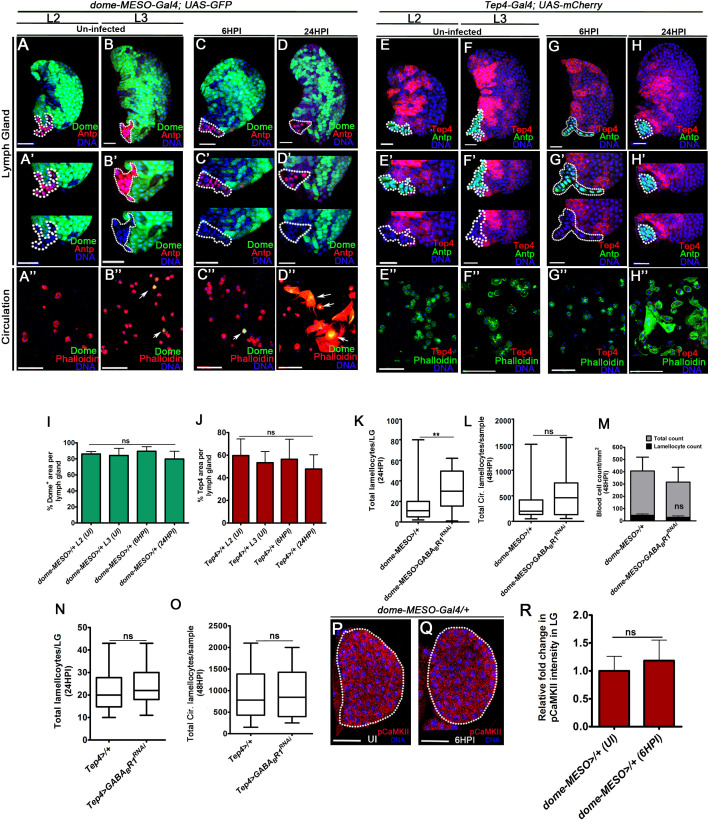
GABA receptor signaling is not required for lamellocyte formation.UI is uninfected, HPI is hours post wasp-infection. Scale bars in panels (A–H’’), and P and Q = 20 µm. In lymph gland, lamellocytes are analyzed at 24HPI and in circulation at 48HPI. Panels (I, J, M and R) represents mean ± standard deviation (mean ± SD) and in (K, L, N and O) median is shown in box plots and vertical bars represent upper and lowest cell counts and panel. Statistical analysis in panels (I, J, M and R) is unpaired t-test, two-tailed and in panels (K, L, N and O) is Mann-Whitney, two-tailed and. ‘n’ represents the total number of larvae analyzed, and for lymph gland ‘n’ represents lymph gland lobes analyzed. ns is nonsignificant. For better representation of the lymph gland primary lobes, the images shown, have been edited for removal of adjacent tissues (like dorsal vessel and ring gland). (A, B’’) dome-MESO expression (green, dome-MESO-Gal4, UAS-GFP) at (A–A’’) 2nd instar (L2) and (B–B’’) 3rd instar larval stage (L3) is restricted to (A, B) progenitor cells of the lymph gland and (A’, B’) not seen in the posterior signaling center (PSC; marked with Antp in red, and outlined with a white dotted line). (A’’, B’’) dome-MESO expression (green) is detected sparingly in circulating blood cells. Phalloidin (red) marks all blood cells and arrows point to blood cells that are dome positive (green). (C, D’’) dome-MESO expression (green, dome-MESO-Gal4, UAS-GFP) at (C–C’’) 6HPI and (D–D’’) 24HPI is seen in the (C, D) lymph gland progenitor cells and (C’, D’) not in the PSC (marked with Antp in red, and outlined with a white dotted line). (C’’, D’’) dome-MESO expression (green) is detected sparingly in circulating blood cells at (c’’) 6HPI, but is more prominent at (D’’) 24HPI. Phalloidin (red) marks all blood cells, including lamellocytes (large flat cells) and arrows point to blood cells that are dome positive (green). (E, F’’) Tep4 expression (red, Tep4-Gal4, UAS-mCherry) at (E–E’’) 2nd instar (L2) and (F–F’’) 3rd instar larval stage (L3) is restricted to (E, F) progenitor cells of the lymph gland and (E’, F’) not seen in the PSC (marked with Antp in green and outlined with a white dotted line). (E’’, F’’) Tep4 expression (red) is not detected in circulating blood cells. Phalloidin (green) marks all blood cells. (G, H’’) Tep4 expression (red, Tep4-Gal4, UAS-mCherry) at (G–G’’) 6HPI and (H–H’’) 24HPI is seen in the (G, H) lymph gland progenitor cells and (G’, H’) not in the PSC (marked with Antp in green and outlined with a white dotted line). (G’’, H’’) Tep4 expression (red) is not detected in circulating blood cells. Phalloidin (green) marks all blood cells. (I) Quantification of percentage area of dome-positive expression in the lymph glands obtained from 2nd instar dome-MESO-Gal4, UAS-GFP, uninfected (n = 8), 3rd instar dome-MESO-Gal4, UAS-GFP, uninfected (n = 13), dome-MESO-Gal4, UAS-GFP, 6HPI (n = 17, ns compared to 2nd instar dome-MESO-Gal4, UAS-GFP, uninfected) and dome-MESO-Gal4, UAS-GFP, 24HPI (n = 8, ns, 3rd instar dome-MESO-Gal4, UAS-GFP, uninfected). (J) Quantification of percentage area of Tep4-positive expression in the lymph glands obtained from 2nd instar Tep4-Gal4, UAS-mCherry>/+, uninfected (n = 23) and 3rd instar larvae Tep4-Gal4, UAS-mCherry>/+, uninfected (n = 6), Tep4-Gal4, UAS-mCherry>/+, 6HPI (n = 31, ns compared to 2nd instar Tep4-Gal4, UAS-mCherry>/+, uninfected) and Tep4-Gal4, UAS-mCherry>/+, 24HPI (n = 18, ns compared to 3rd instar Tep4-Gal4, UAS-mCherry>/+, uninfected). (K, L) Expressing GABABR1RNAi in progenitor cells (dome-MESO-Gal4, UAS-GFP; UAS- GABABR1RNAi) does not reduce lamellocyte formation in the (K) lymph gland and (L) circulation. (K) Total lamellocyte quantification in lymph gland, in dome-MESO-Gal4, UAS-GFP/+ (control, n = 31), dome-MESO-Gal4, UAS-GFP; UAS-GABABR1RNAi (n = 24, **p=0.0028), and (L) total lamellocyte quantification in circulation, dome-MESO-Gal4, UAS-GFP/+ (control, n = 30), dome-MESO-Gal4, UAS-GFP; UAS-GABABR1RNAi (n = 24, ns). (M) Quantification of total circulating blood cell numbers per mm2 in animals at 48HPI. Represented here are the numbers of lamellocytes (black bar) and total cell counts (gray bar) counted per mm2. No difference is detected both in overall blood cell density and lamellocyte density in dome-MESO-Gal4, UAS-GFP/+ (control, n = 5), dome-MESO-Gal4, UAS-GFP; UAS-GABABR1RNAi (n = 5, ns). (N, O) Expressing GABABR1RNAi in progenitor cells using using Tep4-Gal4 driver (Tep4-Gal4, UAS-mCherry; UAS- GABABR1RNAi) does not affect lamellocyte formation in the (N) lymph gland and (O) circulation. (N) Total lamellocyte quantification in lymph gland, Tep4-Gal4, UAS-mCherry/+ (control, n = 10), Tep4-Gal4, UAS-mCherry; UAS- GABABR1RNAi (n = 11, ns compared to control), (O) total lamellocyte quantification in circulation, Tep4-Gal4, UAS-mCherry/+ (control, n = 33), Tep4-Gal4, UAS-mCherry; UAS- GABABR1RNAi (n = 30, ns). (P–R) No change in pCaMKII levels is detected in control (dome-MESO>GFP/+) lymph glands obtained from (P) uninfected and (Q) infected (6HPI) animals. (R) Relative fold change in pCaMKII intensity of dome-MESO>GFP/+ in UI (control, n = 12), and at 6HPI (n = 13, ns).Figure 2—figure supplement 1—source data 1.Contains numerical data plotted in Figure 2—figure supplement 1I,J,K,L,M,N,O and R.